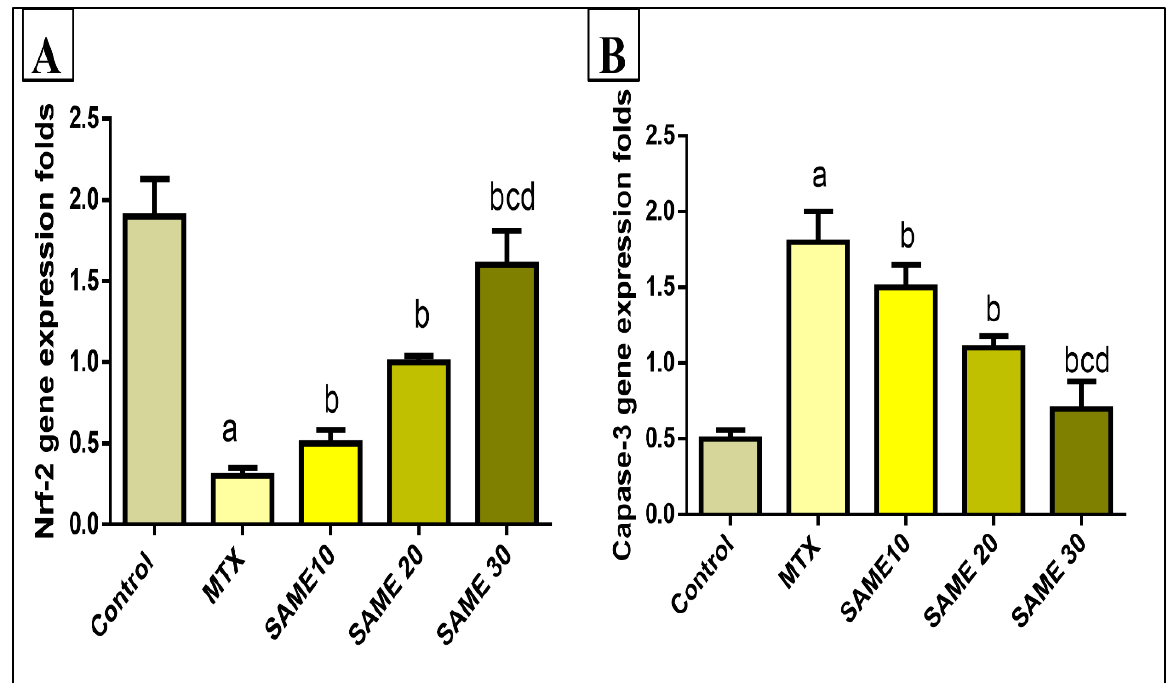
Figure 8. Effect of the SAME pre-treatment on ( A ) Nrf-2 expression level ( B ) Caspase-3 expression level. Hepatotoxicity was induced by a single I.P injection of MTX (20 mg/kg). SAME 10,20 and 30 were given orally once daily for 5 consecutive days and a single injection of MTX on the sixth day. Data expressed as mean ± SD ( n = 8/group). Significant difference vs. a respective control, b respective MTX group, c respective SAME 10 group, d respective SAME 20 group each at p < 0.05.